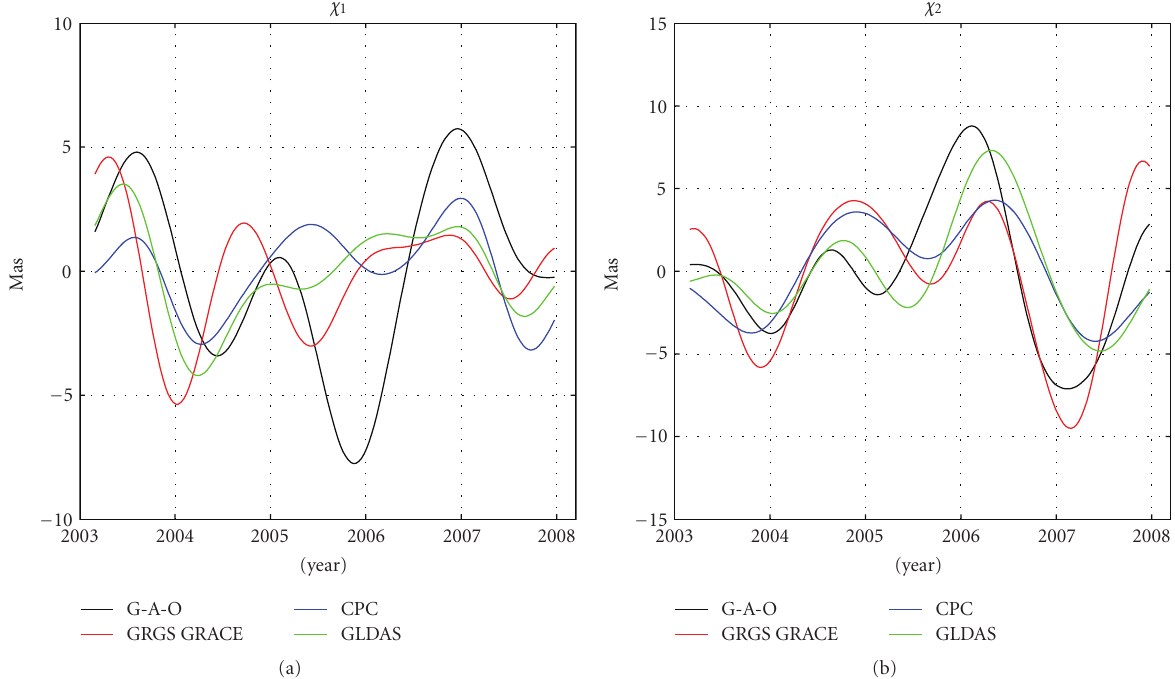
Figure 6: Interannual variations derived from the geodetic residual (G-A-O), GRACE, CPC, and GLDAS-based excitations. We observed a reasonably agreement for the χ 2 term.